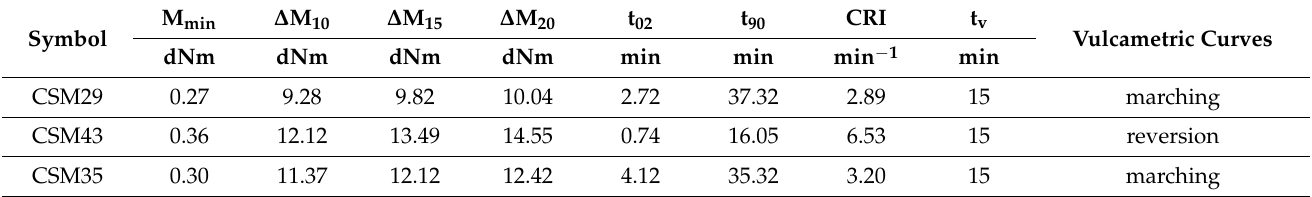
Table 2. Vulcametric parameters of the unfilled CSM compositions determined at the temperature of 160 ◦